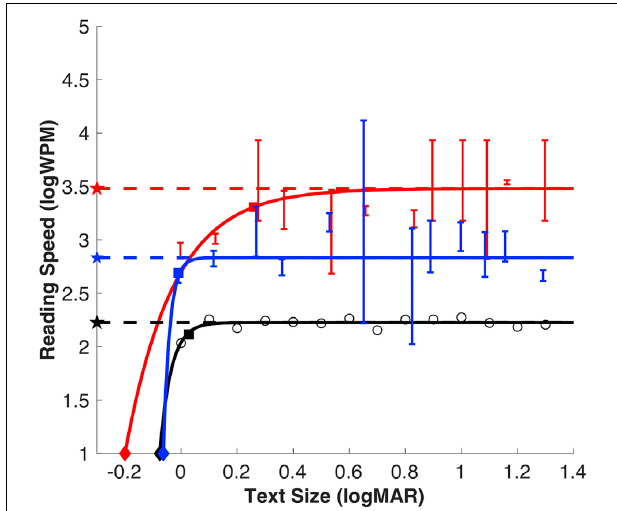
FIGURE 3 | Illustration of exponential reading function from a representative for each reading task in the pilot study: True/false (blue), word/non-word (red) and MNREAD (black; raw data as open red circles). Reading estimates for MRS (dashed line with filled stars), CPS (filled squares with dashed lines) and RA (filled diamonds). Threshold duration estimates for true/false and word/non-word tasks plotted as solids lines in their respective colors, error bars show 95% confidence intervals.